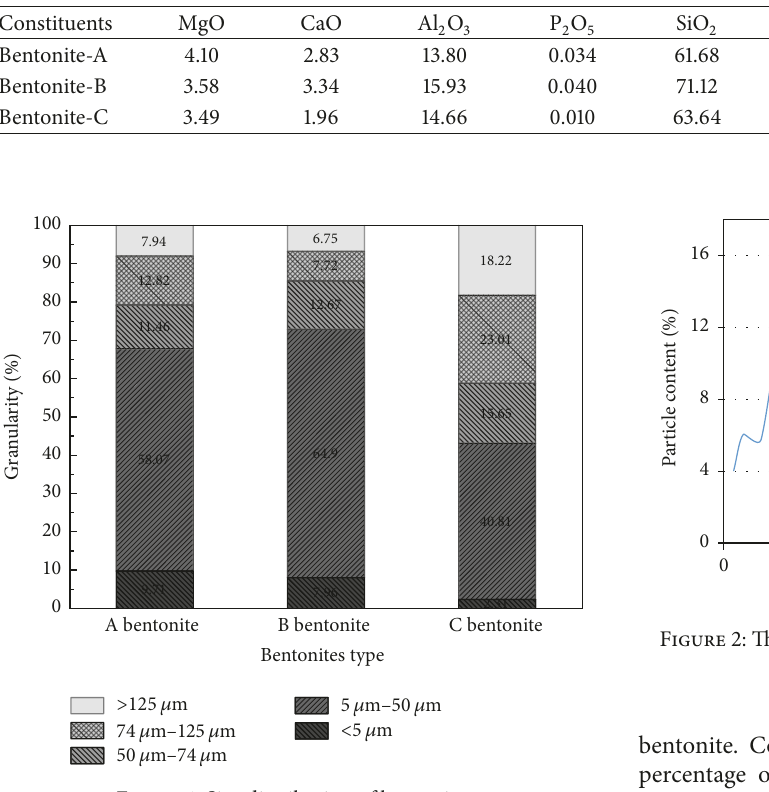
Figure 1: Size distribution of bentonite.